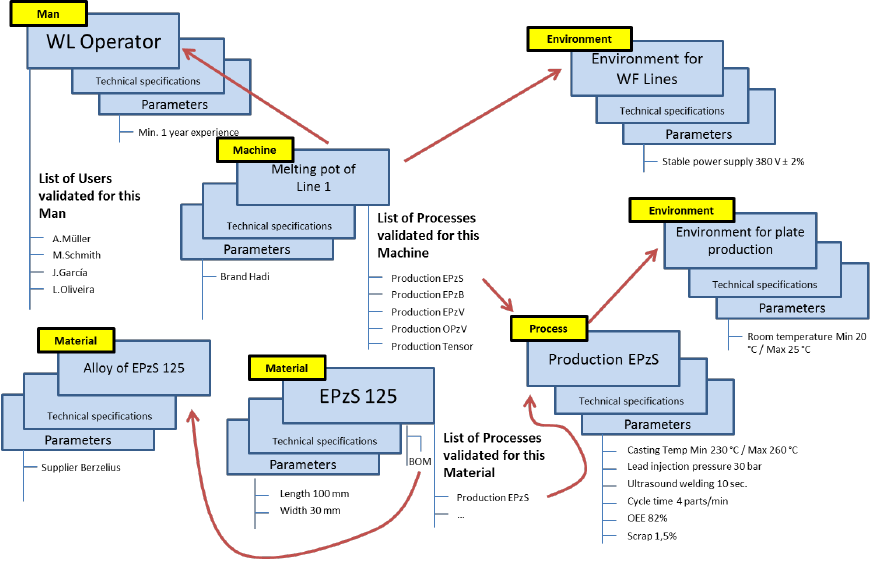
Figure 6. Example of the PLM structure of items (OEE: Overall Equipment Effectiveness).